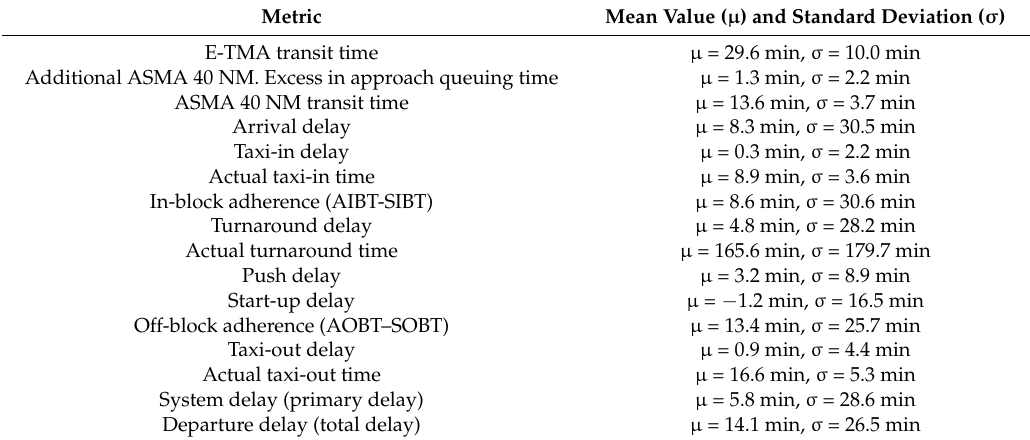
Table 6. Statistical characterisation of the aircraft flow through the airspace/airside integrated operations.